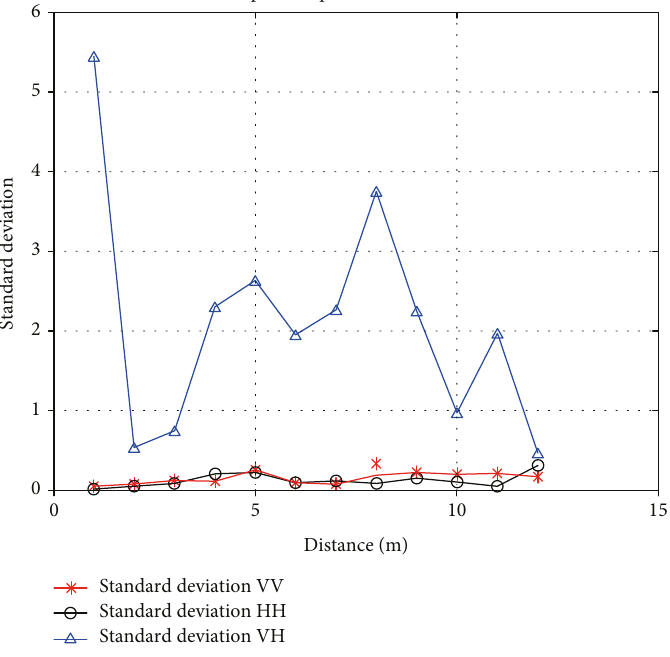
Figure 8: Standard deviation for point-to-point data measured in the computer room to polarizations V-V, H-H, and